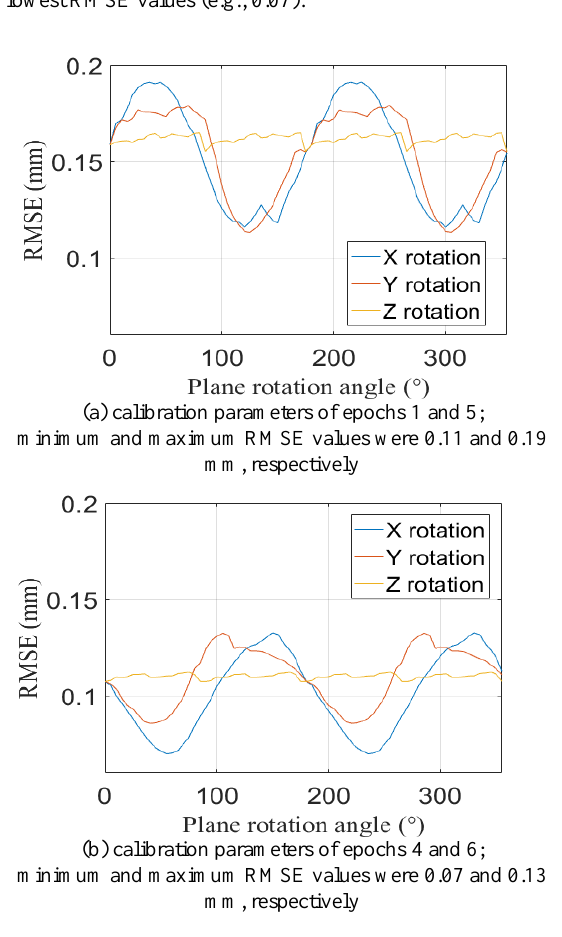
Figure 6. Stability analyis of stationary imaging-system and rotating